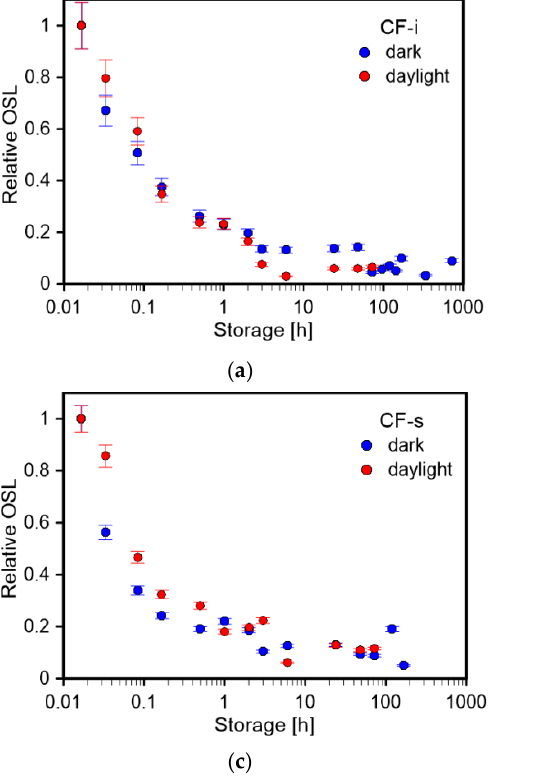
Figure 9. Fading characteristics-relative OSL (normalized to the readout immediately after irradia- tion) as a function of storage time after irradiation of 0.6 Gy. The graph compares fading after dark storage and daylight storage for ( a ) CF-i, ( b ) CSP-s, ( c ) CF-s, and ( d )